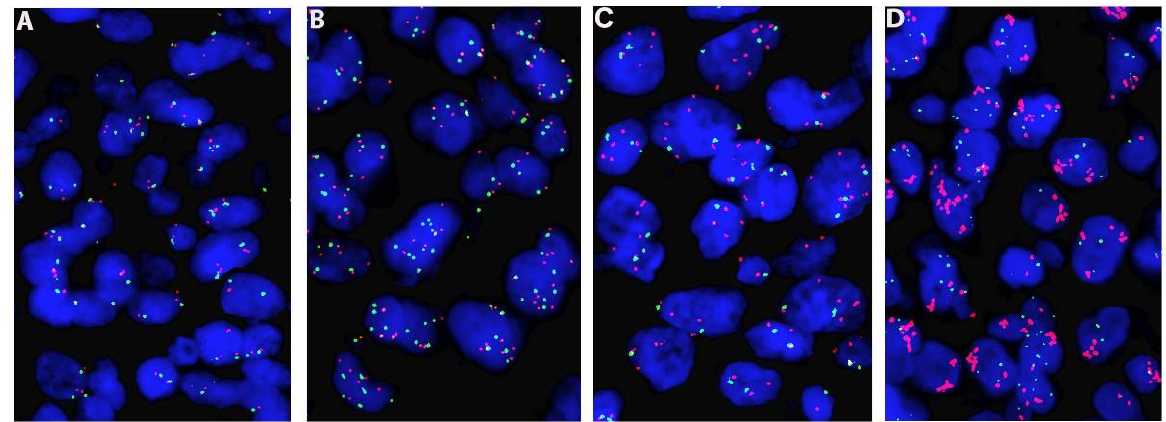
Figure 1. Fluorescence in situ hybridization ( FISH) analysis using MET/CEP7 probes (×60). ( A ): MET negative; ( B ): Polysomy 7 (copy number gain detected in both MET and CEP7 ); ( C ): MET amplification (copy number gain in MET , not in CEP7 , MET/CEP7 ratio > 1.8); ( D ): MET amplification (clusters of MET signals). FISH probe signals: MET in red and centromere 7 ( CEP7 ) in green.